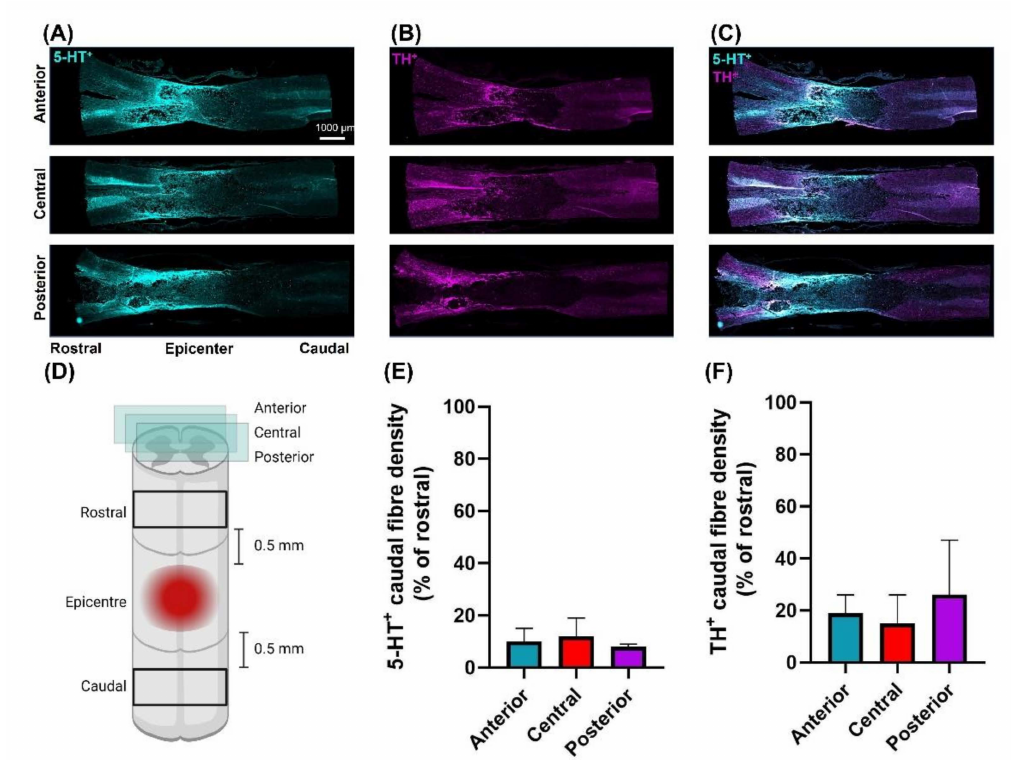
Figure 6. Representative immunohistological images of longitudinal spinal cord sections, anterior (top), central (middle), and posterior (bottom) ( A – C ). Stains from left to right are 5-HT + , TH + and merged. Each quantified section was 500 µ m removed from the one previous ( D ) Schematic depicting the anatomical location of where densities of 5-HT + and TH + were measured 0.5 mm rostral and caudal to the epicenter with the area of study being 2 mm wide by 1 mm tall. The associated density plots comparing the caudal to the rostral stain density across anterior, central and posterior sections for 5-HT + ( E ) TH + ( F ). Caudal sparing was quantified as 9 ± 2% and 18 ± 9% relative to rostral for 5-HT + and TH + , respectively (n = 3). Data are presented as means ± standard